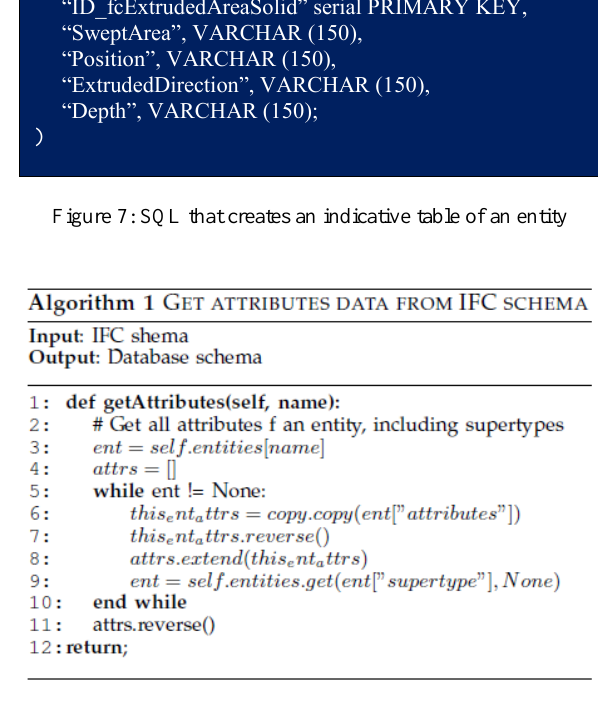
Figure 8: Get attributes data from IFC schema